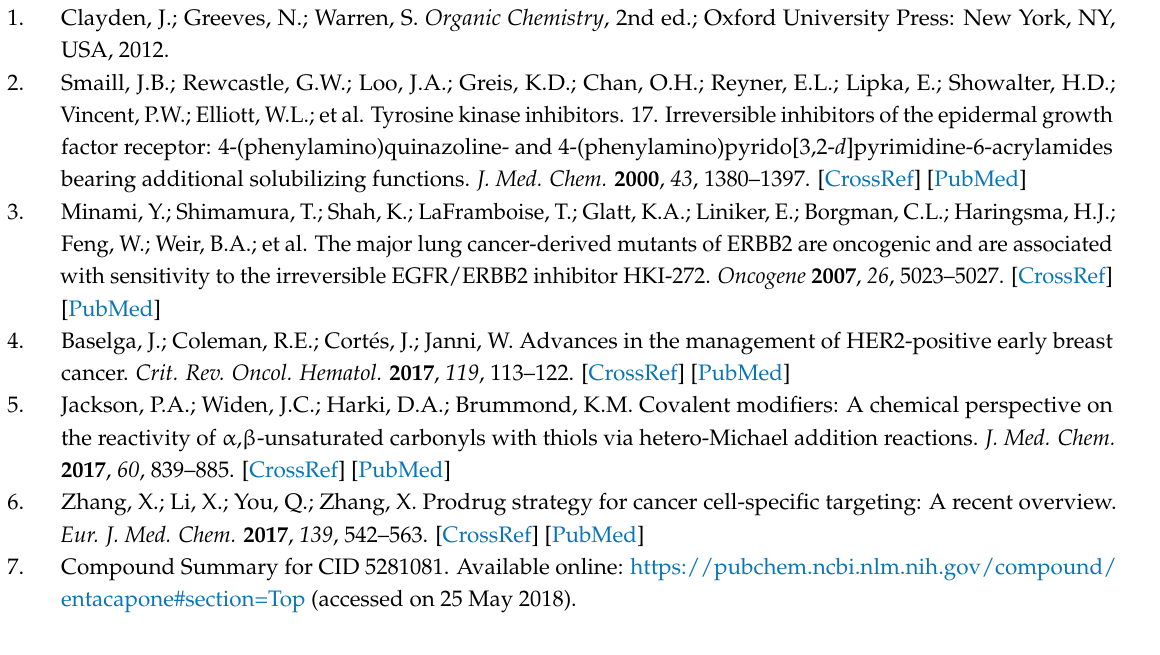
Supplementary Materials: The following are available online: Table S1. Properties of novel compounds calculated with Chemicalize.org program. The Lipinski and Gelovani parameters; Table S2. Analytical and spectral data of compounds 4a – f and 5a – f ; Table S3. 1 H and 13 C NMR spectra of amides 4a – f and 5a – f ; Table S4. Interaction of fumardiamide 4b with GSH; Figure S1. Interaction of fumardiamide 4b with GSH ( (cid:7) ). Control: ( N -(benzyloxy)- N (cid:48) -{4-[(6-methoxyquinolin-8-yl)amino]pentyl}butanediamide) ( • ). Spectra of all